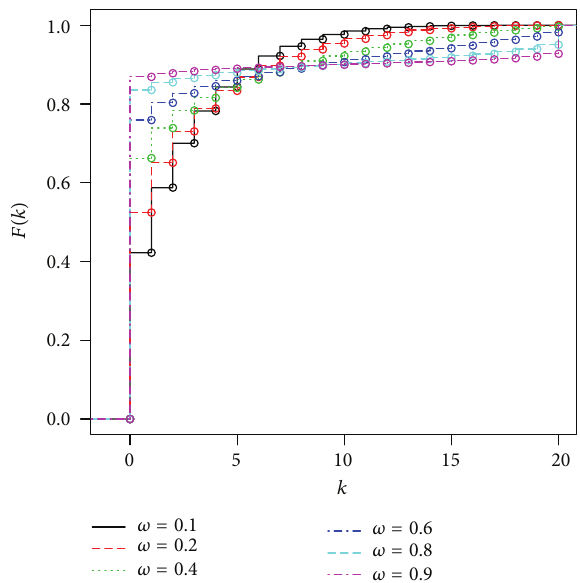
Table 2: Themethodofmoments estimatesoftheshapeparameters, 𝑎 and 𝑏 , of Beta mixing distribution and the limiting correlation 𝜔 .